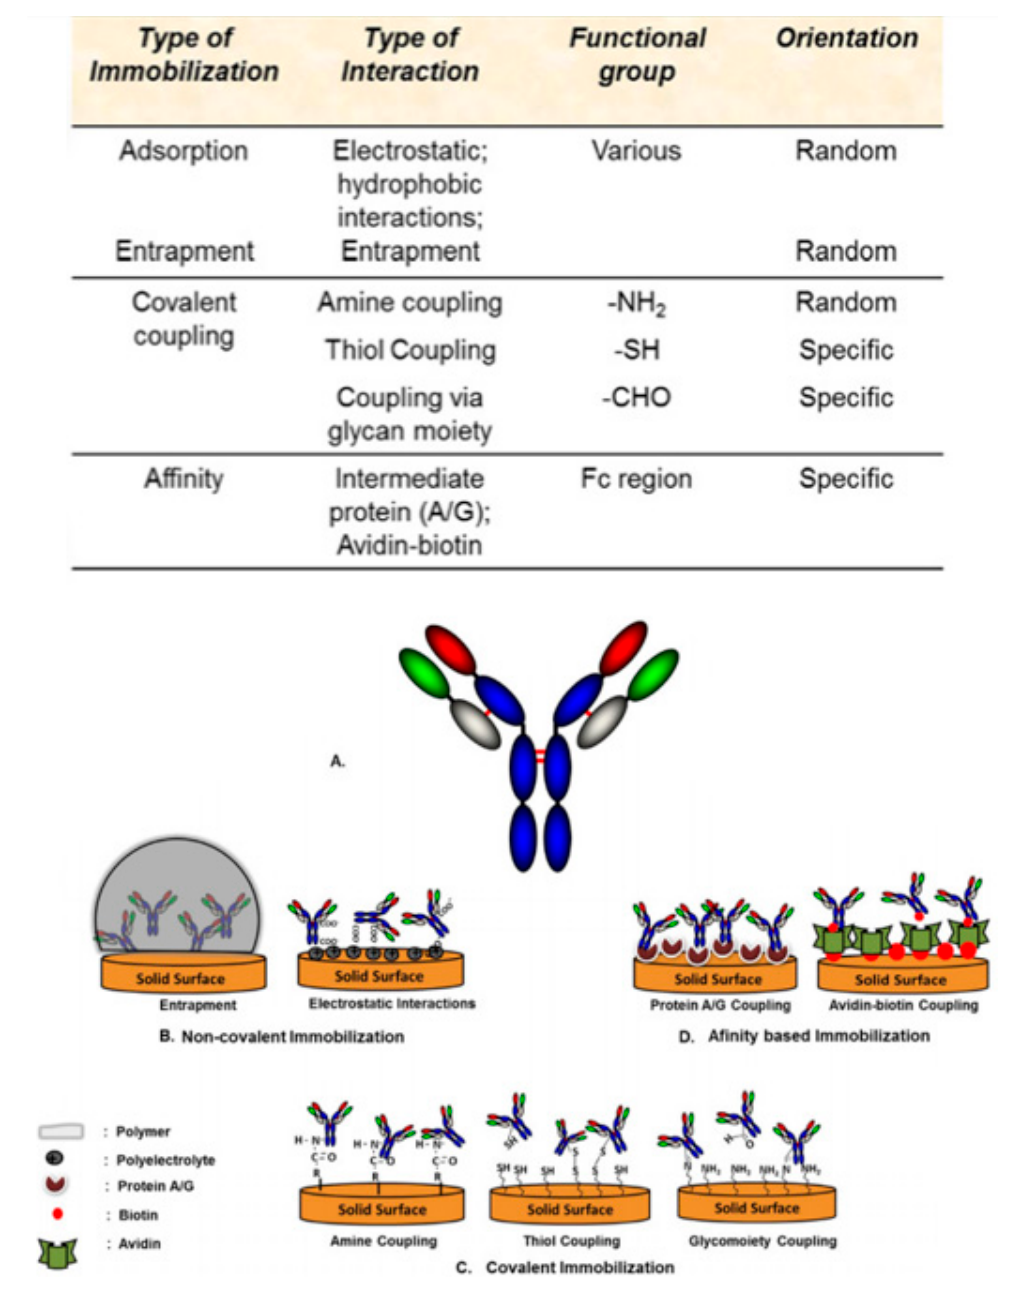
Figure 4. Overview of different functional groups utilized for different modes of antibody immobilization on to the biosensor’s surface and schematic representation of different immobilization techniques used to immobilize antibodies on to a biosensor’s surface. ( a ) Typical antibody structure; ( b ) non-covalent immobilization of antibodies on to a biosensor’s surface through entrapment and electrostatic interactions; ( c ) covalent immobilization of antibodies on to a biosensor’s surface through various functional groups such as aldehyde, thiol, and amine groups; ( d ) affinity-based immobilization of antibodies on to a biosensor’s surface via protein A/G coupling and avidin-biotin coupling [78] .